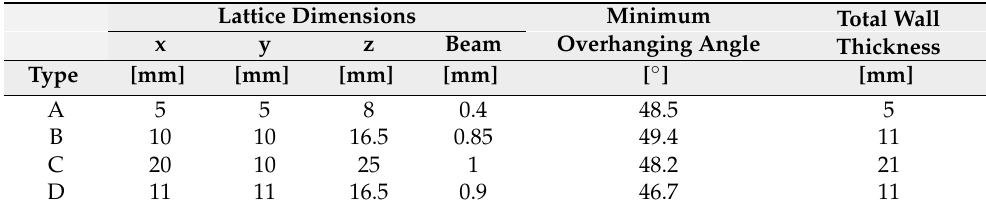
Table 4. Lattice cell geometry.